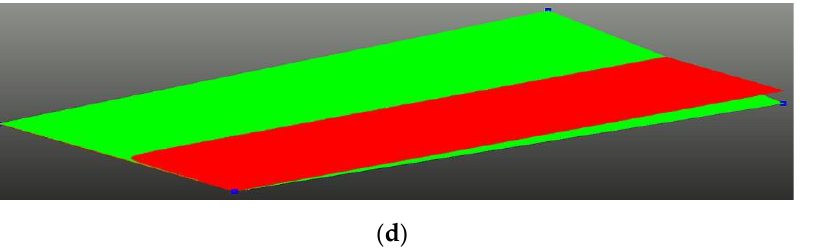
Figure 3. Synthetic point cloud before (red) and after correction (green). Blue dots are the GCPs. The whole process is shown separately by four basic steps: ( a ) dZ12; ( b ) dZ1; ( c ) dkappa; ( d ) domega. The combination of these steps is used as corrections of the EOP when the corrected point cloud is going to be generated by space intersection. For the first segment of the ALS strip, the left lidargram is rotated by dkappa and domega, and its projection centre height Z is changed by dZ12 and dZ1. The right lidargram centre of projection is only changed by dZ12. Using such a new, corrected EOP, the new point cloud is calculated by photogrammetric intersection.